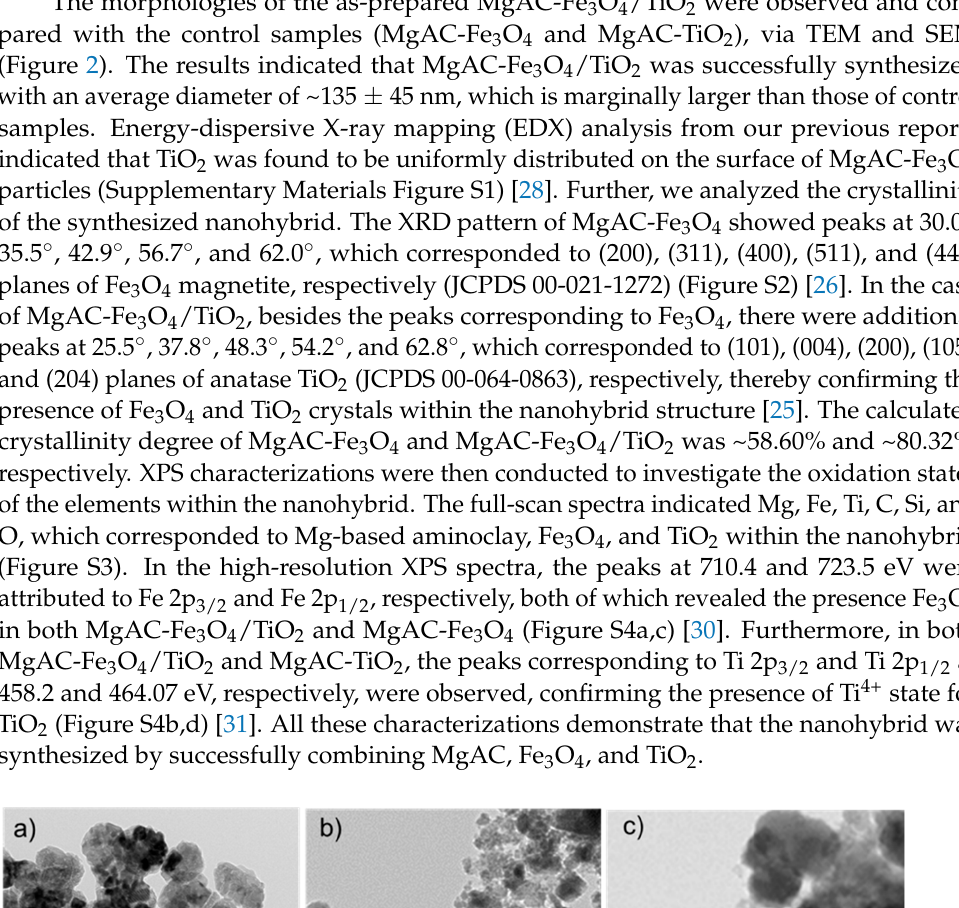
Figure 3. Absorption spectra for the oxidation of ABTS in the presence of H 2 O 2 by MgAC- Fe 3 O 4 /TiO 2 , MgAC-Fe 3 O 4 , and MgAC-TiO 2 , with or without UV-light irradiation. To better understand the peroxidase-like activity, the steady-state kinetic assays of MgAc-Fe 3 O 4 /TiO 2 were performed in the presence and absence of UV-light conditions us- ing ABTS and H 2 O 2 as substrate. MgAc-Fe 3 O 4 /TiO 2 showed the typical Michalis–Menten kinetics toward H 2 O 2 and ABTS in both cases (Figure S5). Its Michaelis–Menten constant ( K m ) and the maximal reaction velocity ( V max ) values were determined based on the dou- ble-reciprocal Lineweaver–Burk plots (Table S1). Under the UV-light irradiation, the K m values for both ABTS and H 2 O 2 were lower than those without UV-light condition, prov- ing the significant enhancement of the nanohybrid’s affinity toward both substrates. Fur- thermore, the V max values of MgAc-Fe 3 O 4 /TiO 2 toward ABTS and H 2 O 2 in the presence of